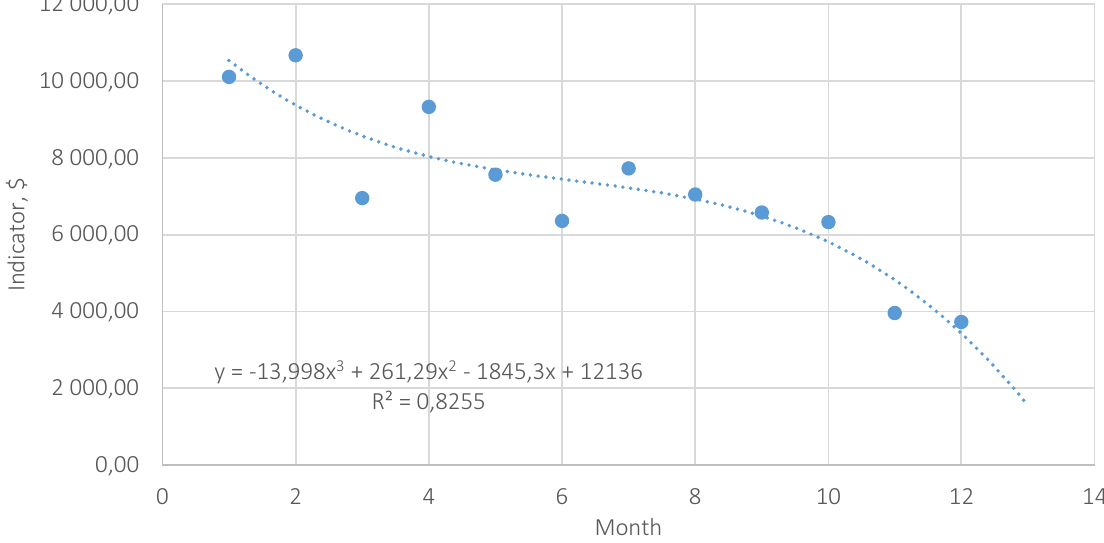
Figure 1. Forecasting of the Bitcoin rate to the USD for the first quarter of 2019